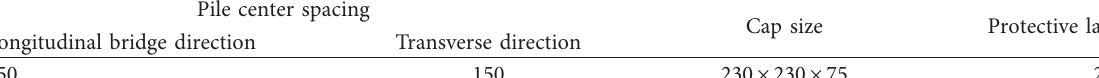
Table 1: Bearing platform size layout (mm).